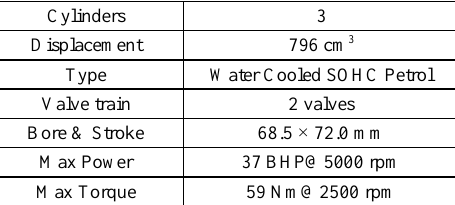
Table 1. Maruti 800 engine specification